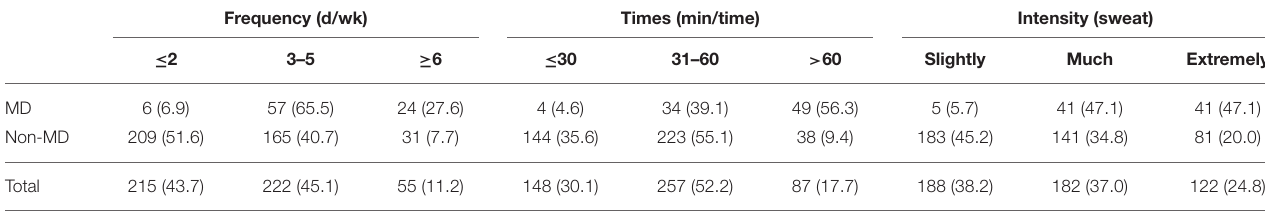
MD, muscle dysmorphia; Difference test in exercise frequency for groups with and without muscle dysmorphia: Pearson X 2 = 67.95, p < 0.001; Difference test in exercise time for groups with or without muscle dysmorphia: Pearson X 2 = 115.55, P < 0.001; Difference test in exercise intensity for groups with and without muscle dysmorphia: Pearson X 2 = 201